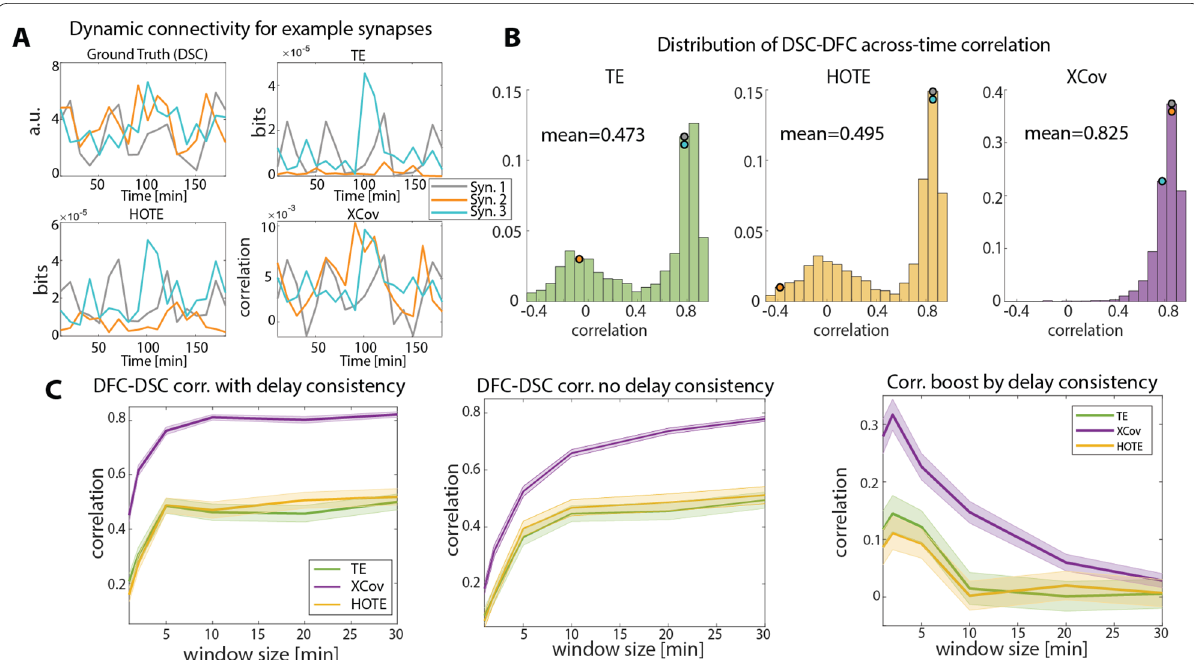
Fig. 5 Relationship between dynamic synaptic and functional connectivity. A Dynamic connectivity for 3 example synapses, T left: ground truth dynamics of synaptic weights (DSC). Top right: transfer entropy DFC. Bottom left: HOTE DFC. Bottom right: cross-covariance DFC. B Distribution of the across-time correlation coefficients between DSC and DFC, T cross-covariance. Colored dots show where the synapses in panel A are in the correlation distributions. C Average correlation between DSC and DFC over time for different sizes of the moving window. Shaded areas are SEM across neuron pairs. Left: DFC keeping delay consistency (i.e., measures computed only at previously estimated delay); Middle: DFC without delay consistency; Right: boost in correlation between DFC and DSC when keeping delay consistency (difference between left and middle